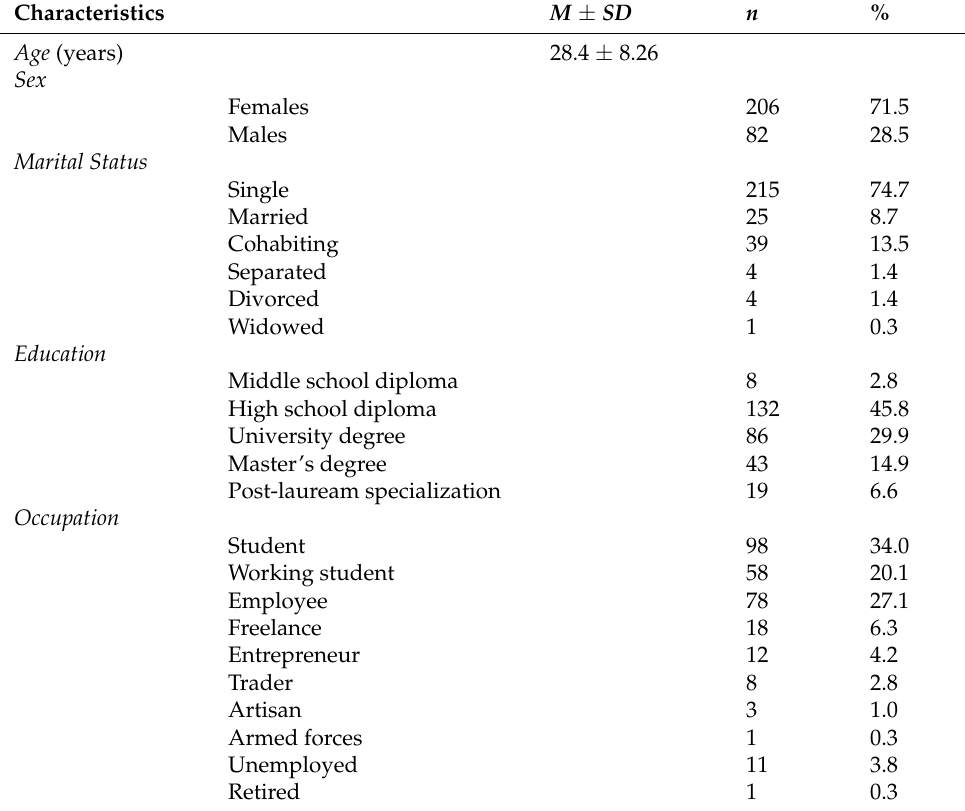
Table 1. Demographic characteristics of the sample ( N =